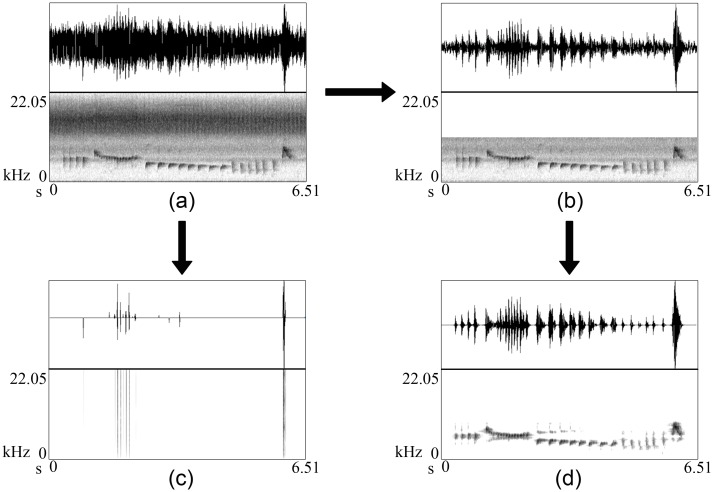
A deliberate denoising example.(a) A North Island robbin song (sampling frequency 44,100 Hz) and (b) its down-sampled song to 22,000 Hz. (c) and (d) are their denoised songs.